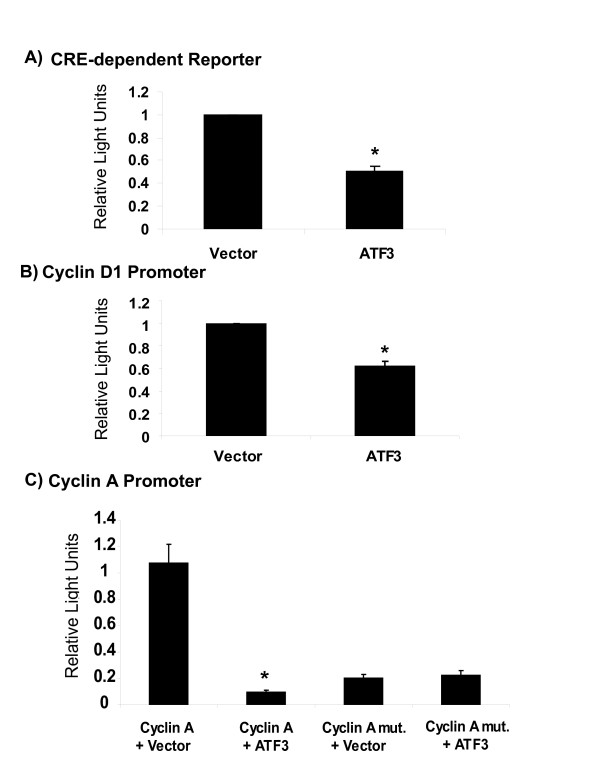
ATF3 suppresses CRE-dependent transcription. Primary chondrocytes were cotransfected with a CRE reporter (A), a cyclin D1 promoter (-1745CD1LUC, B) or cyclin A promoter plasmids (p707cycAluc and p707cycAlucMut; C), pcDNA3 (control) or an ATF3 expression vector, and pRLCMV. 24 hours after transfection, cells were harvested, firefly luciferase activity was measured and normalized to Renilla luciferase activity. Data represent averages and SEM from three independent experiments, performed in quadruplicate each (*: p < 0.05). ATF3 overexpression suppressed the CRE reporter, cyclin D1 and cyclin A wild type promoters significantly, whereas the mutant cyclin A construct showed no response to ATF3 overexpression.